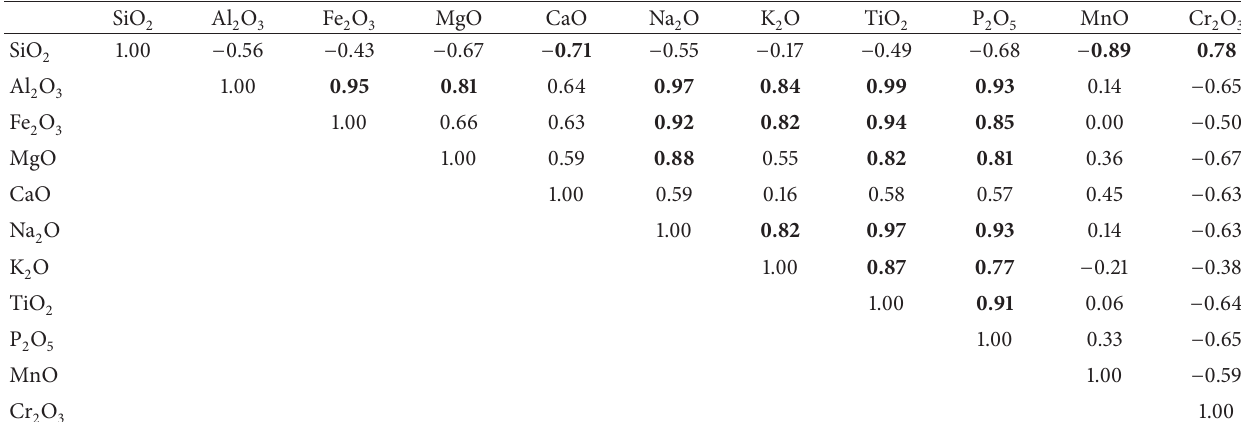
Table 5: Correlation relations for major oxides.